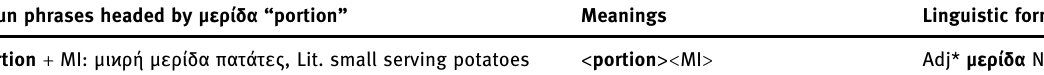
Table 4: The dish name denoting noun is headed by μερίδα “ serving. ” The MI is denoted by a nominal modi fi er of the head or entailed by a Substance denoting modi fi er Noun phrases headed by μερίδα “ portion ” Meanings Linguistic